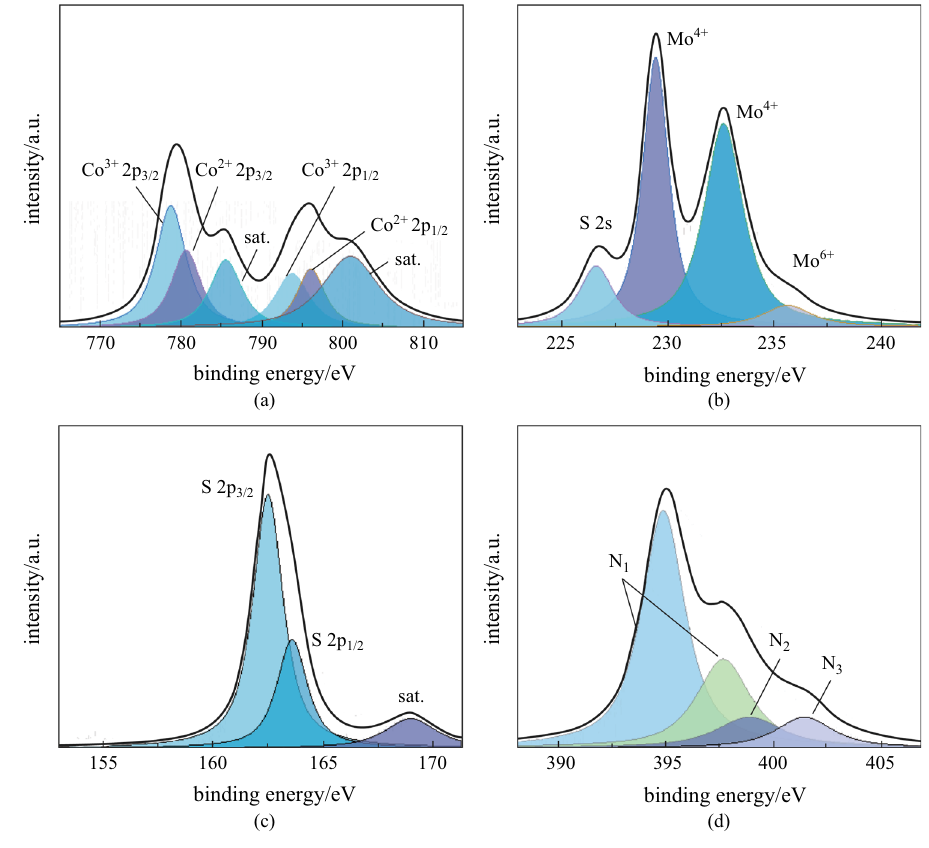
Fig. 5 XPS spectra of MOS/CoS/CC-6 h electrocatalyst. a Co, b Mo, c S, d